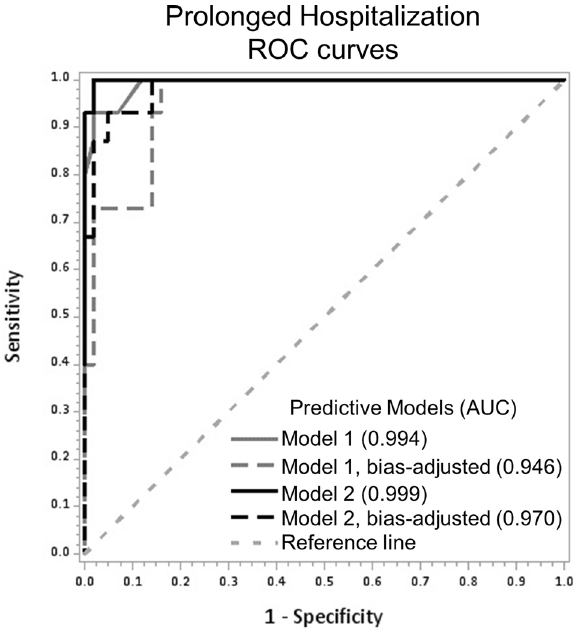
Figure 3. Receiver Operator Characteristic (ROC) Curves for Five miRNAs Differentiating Infants with Prolonged Hospitalization (≥ 14 Days) from Those Hospitalized for < 14 Days. ROC curves for performance of Model 1, containing let-7b-5p, miR-10b-5p, miR-128-3p, miR-30c-5p, and miR-421, and Model 2, containing the same miRNAs and gestational age. For Model 2, miR-10b-5p was dropped from the model due to lack of convergence. AUC area under the ROC